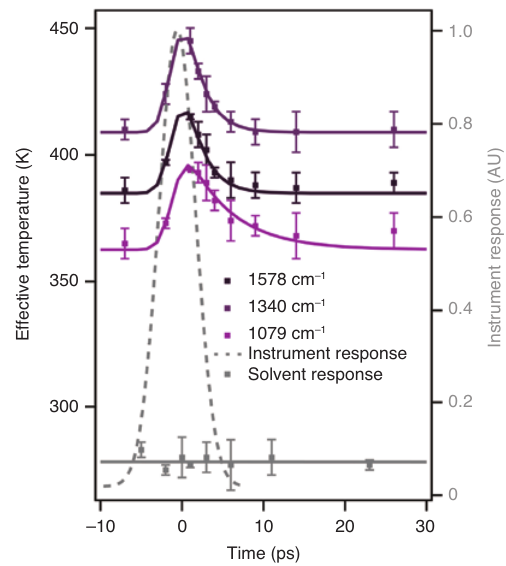
Figure 4: The temperature of 4-nitrobenzenthiol adhered to a plasmonic antenna determined using AS-to-S ratios obtained with ultrafast Raman